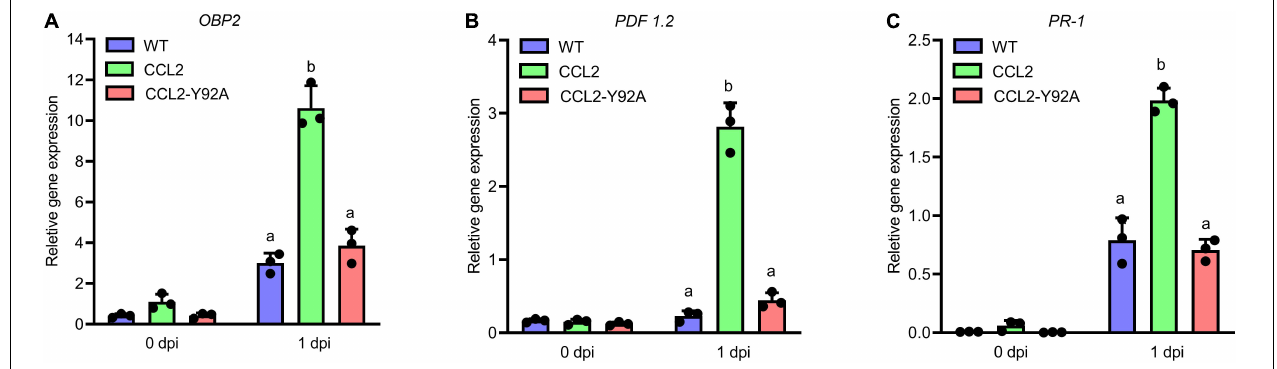
FIGURE 4 | CCL2 enhances induction of Arabidopsis defense gene expression in response to B. cinerea . Four-week-old Arabidopsis plants (WT, CCL2, and CCL2-Y92A lines) were spray-inoculated with B. cinerea (5 × 10 5 spores mL − 1 ). Leaves were harvested at 0 and 1 dpi for RNA extraction. Transcript levels of OBP2 (A) , PDF1.2 (B) , and PR-1 (C) were determined by qPCR. Data were normalized with regard to the Arabidopsis reference gene expG . Data represent mean values ± SE of three independent experiments. The letters a and b signify a between-group difference at the P ≤ 0.05 level. Two-way ANOVA and post hoc analysis by Tukey’s multiple-comparison test were used to calculate significant differences between transgenic lines and WT plants.